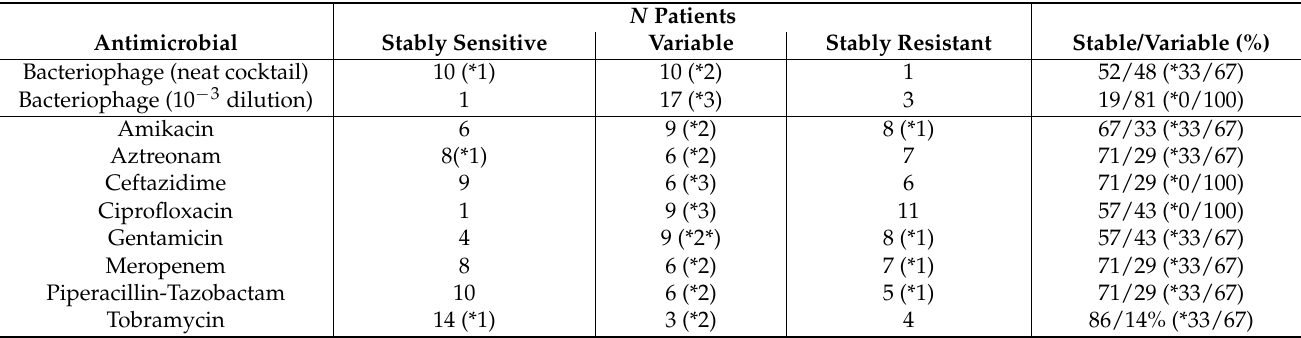
Table 2. Inter-patient antibiogram and plaque assay